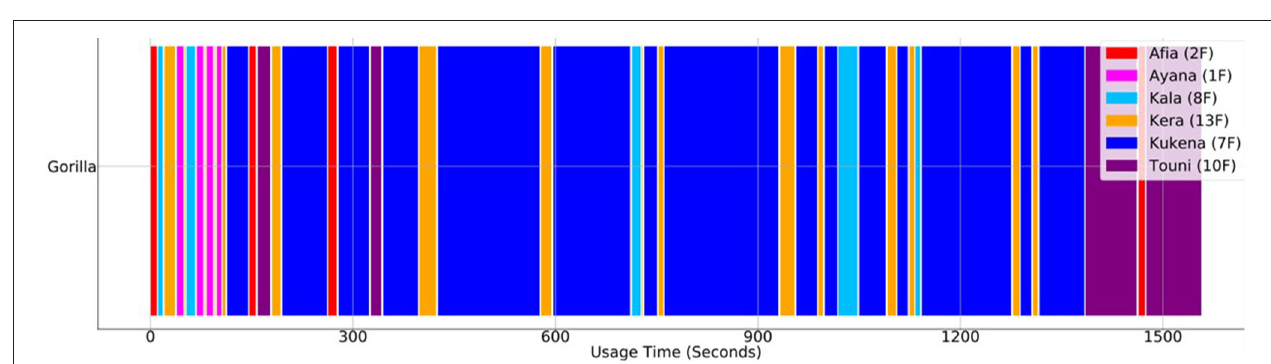
FIGURE 8 | Order, Frequency & Duration of Use. The figure shows the order, duration and frequency each gorilla engaged with the Gorilla Game Lab device over the same 30-min segment as shown in Figure 7 . The age and sex of the gorilla is indicated in brackets (i.e., 1F indicates a 1 year old female).